Question: Condense the content of this figure into a single sentence.
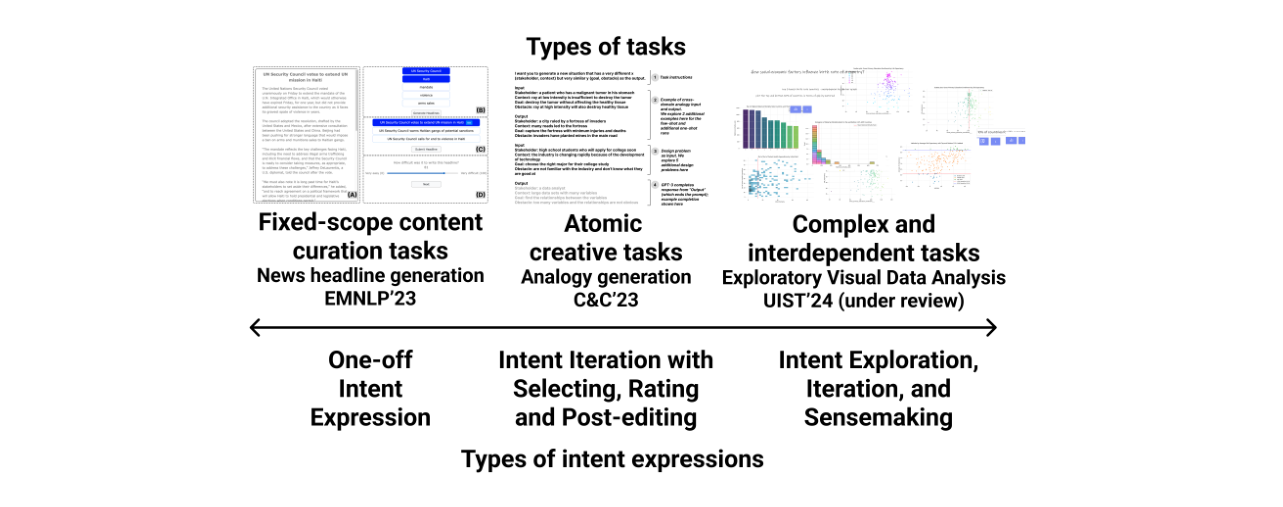
Answer: The spectrum of human intent expression ranges from one-off intent expression for fixed-scope content curation tasks [9], to intent iteration with selecting, rating and post-editing for atomic creative tasks [10], and intent exploration, iteration and sensemaking for complex and interdependent tasks [7]. The spectrum is based on human-AI interaction paradigms [5, 6].